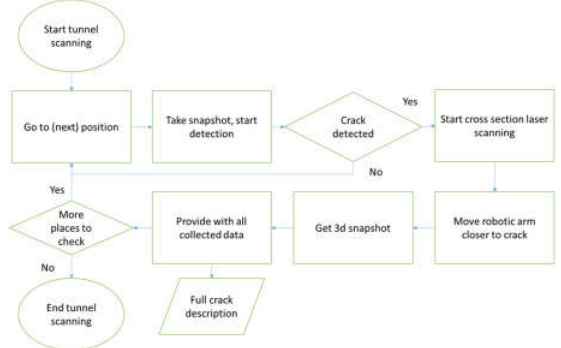
Figure 3. The robotic platform task